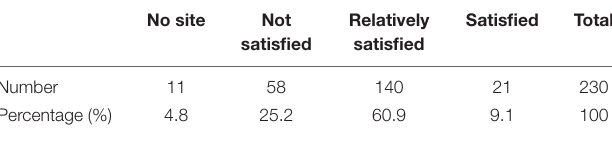
TABLE 5 | Primary and middle school students’ satisfaction of the physical exercise site